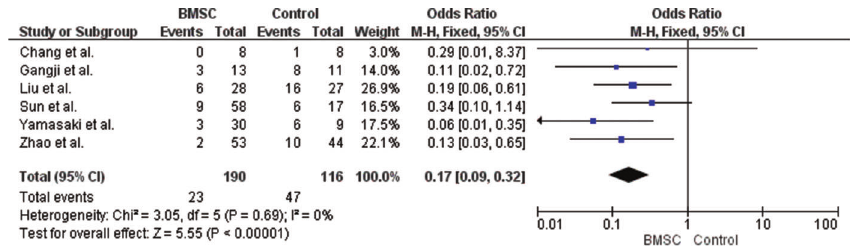
Figure 2 - Forest plot for the progression of osteonecrosis of the femoral head after bone marrow stem cell implantation.